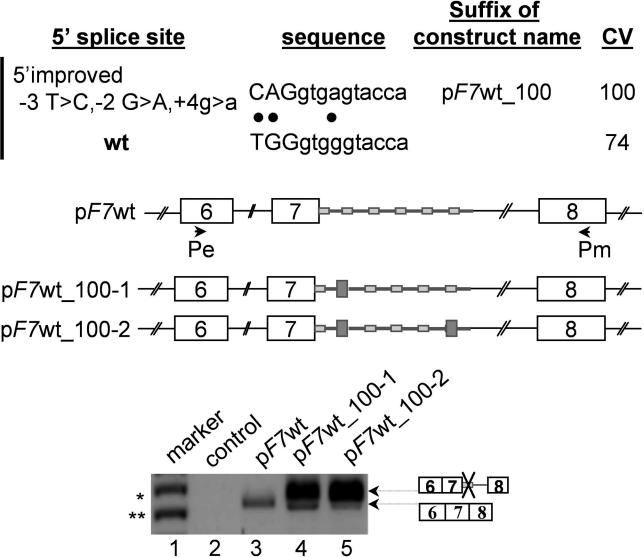
Splicing of a Series of Mutants with IVS7 5′ Pseudo-Sites Perfectly Matching U1snRNATop: Wild-type (lower line) and mutated (upper line) 5′ pseudo-sites in the F7 minigene. Dots show the location of the introduced mutations. Suffix of the constructs' names and the resulting CV of 100 are indicated. Middle: Schematic representation of the constructs transfected in CHO cells. Splice sites matching the consensus are represented by a hatched square (see legend to Figure 2A for the meaning of each symbol). Bottom: RT-PCR amplification of F7 transcripts isolated from CHO cells transfected with the above-mentioned constructs. The products corresponding to the different PCR fragments, as identified by sequencing, are schematically represented on both sides of the figure.